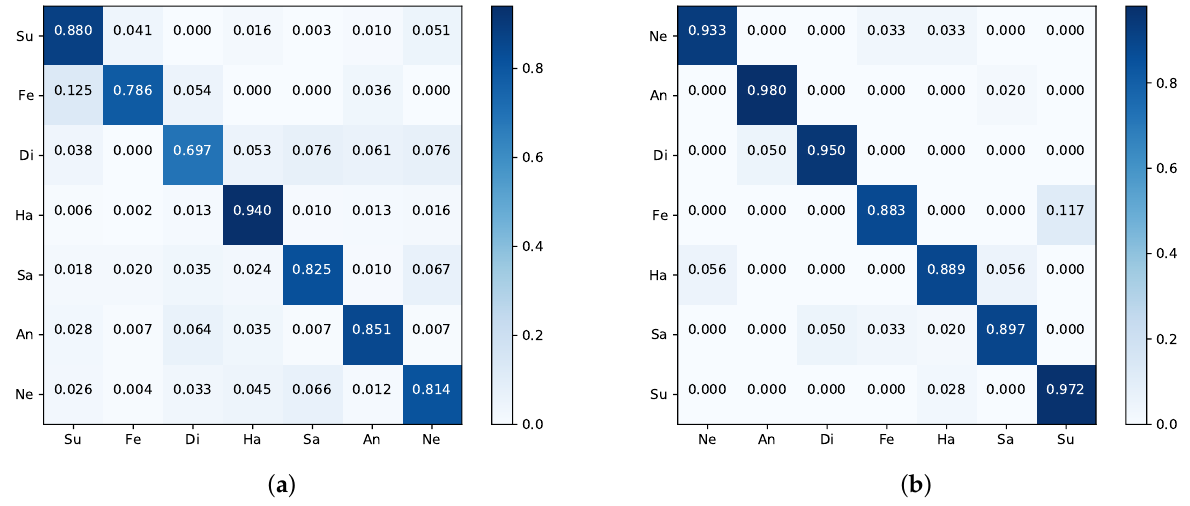
Figure 5. The confusion matrices of our PAL on the ( a ) RAF-DB and ( b ) JAFFE. The darker the color, the higher the accuracy.